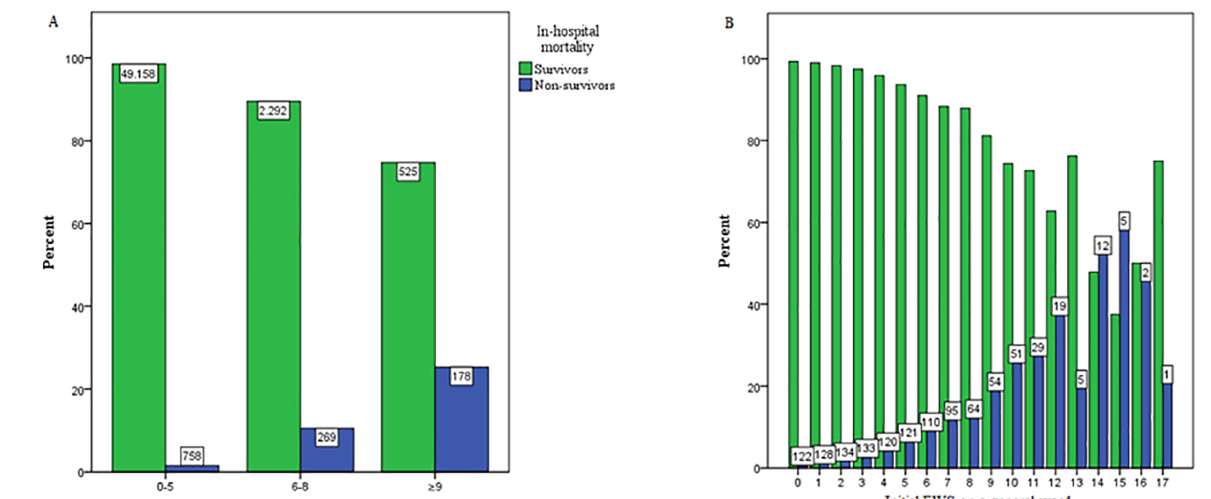
Figure 3. Association between the initial Early Warning Score (EWS) on a general hospital ward and in-hospital mortality rates. Non- survivors died during hospital admission. Survivors were discharged alive. Bars represent mortality or survival rates. Numbers represent the actual number of cases in the specific EWS category depicted. A) EWS categorized in low- (EWS 0-5), medium- (EWS 6-8) and high-risk (≥ 9) groups. B) EWS